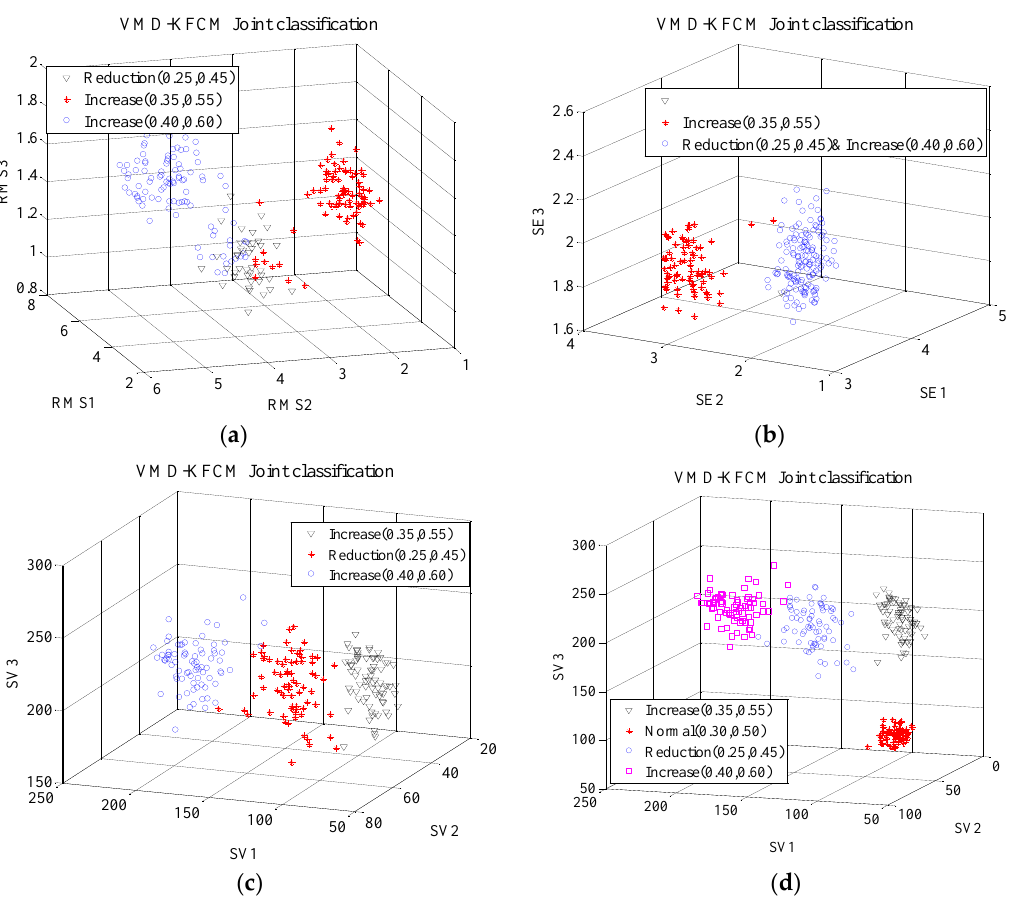
Figure 13. VMD-kernel-based fuzzy c-means clustering (KFCM) classification result of abnormal valve